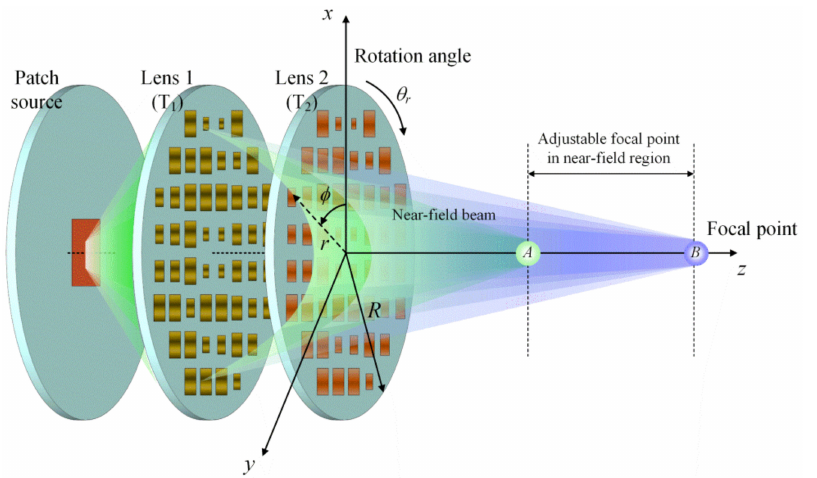
Figure 1. Geometry of the proposed Moir é -inspired MSL system for focusing electromagnetic power in the Fresnel near-field